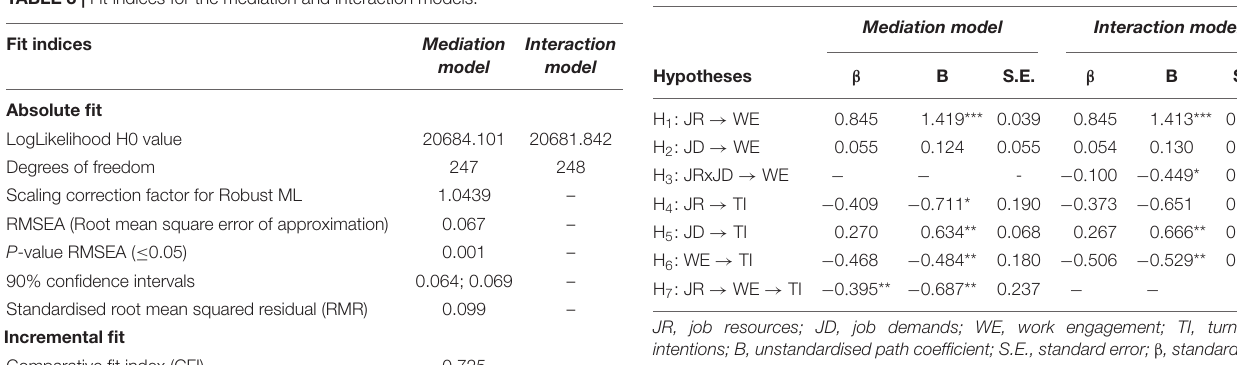
TABLE 4 | Standardised regression weights in the mediation and interaction structural